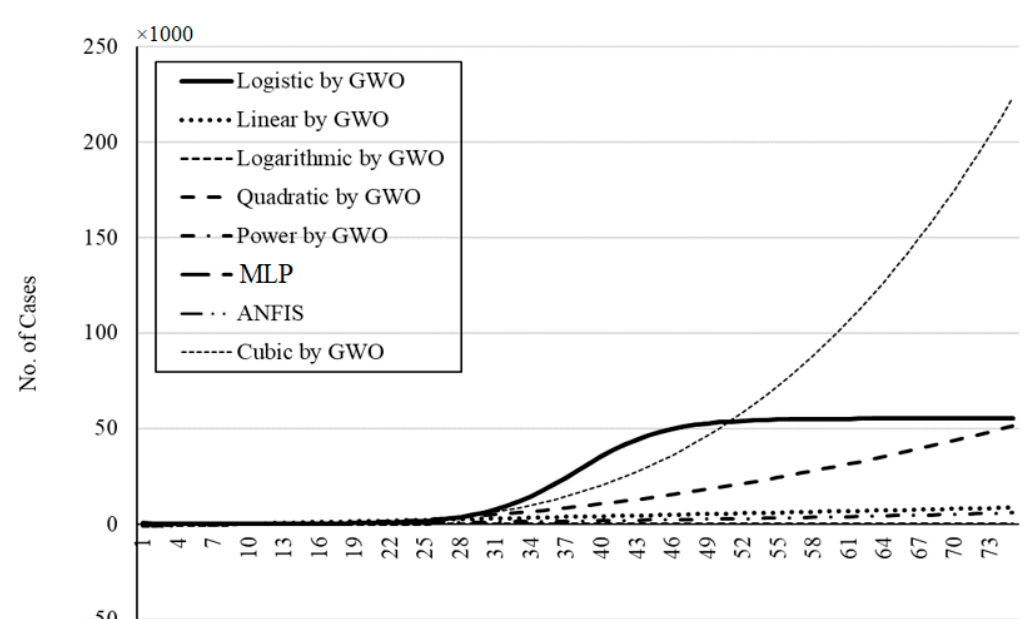
Figure 25. The outbreak prediction for Germany through 75 days.